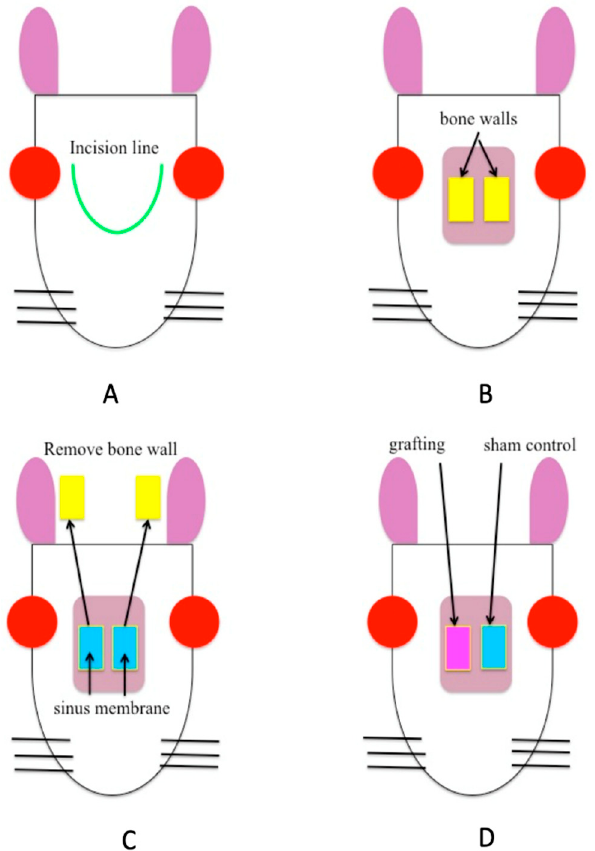
Figure 2. The schematics shows the experimental animal procedure of a rabbit frontal sinus model in the frontal view. Experimental animal procedure: ( A ). Incision line in the rabbit frontal sinus area; ( B ) Excision of 7 × 5 mm windows in the bilateral frontal bone; ( C ). Movement of the bone wall and reflection of the sinus membrane using a mucosal elevator to form sufficient grafting space; ( D ). The left side was used as a sham control (no graft) and the right side received the graft in the BC, BMP-2, and BC+BMP-2 groups.